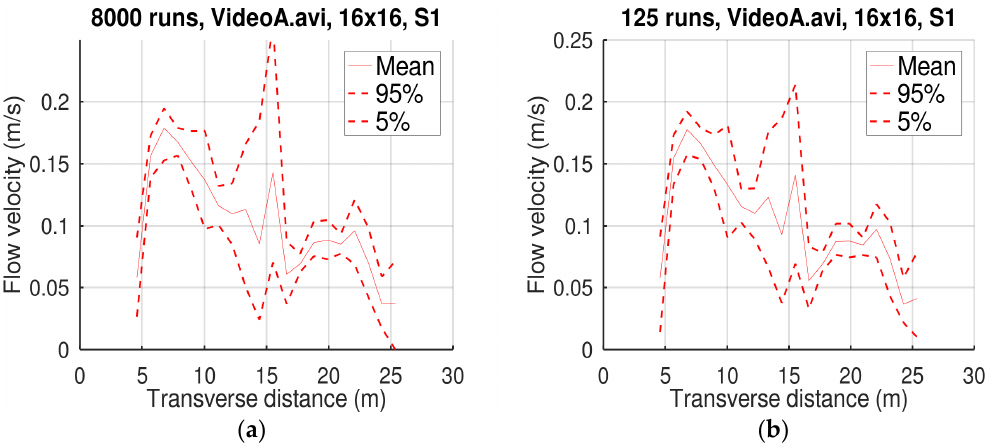
Figure 2. Mean velocity profile and confidence intervals of Monte Carlo simulations with 20 3 ( a ) and 5 3 ( b ) runs, and L =